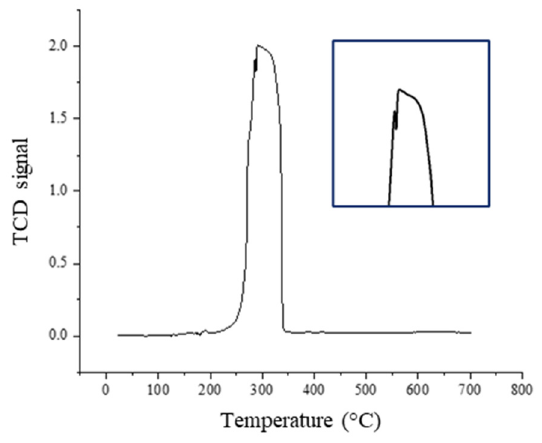
Figure 1. TPR Peak for Ni(NO 3 ) 2 . Note: the framed section of the TPR signal (right-hand side of the